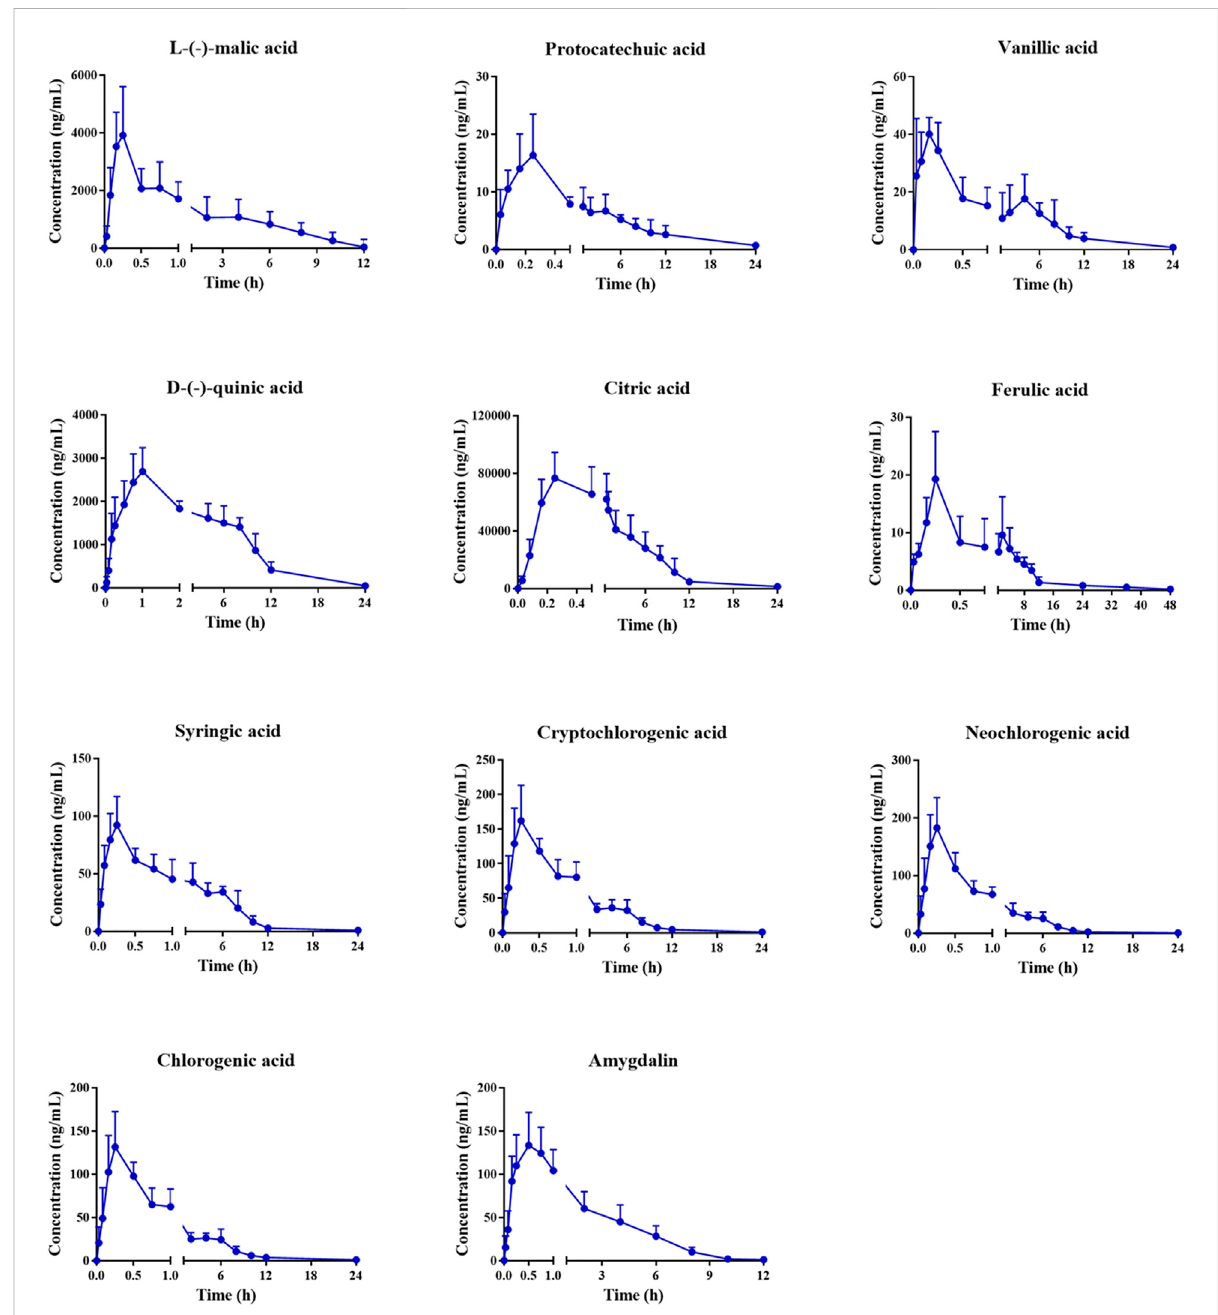
FIGURE 3 Mean plasma concentration – time pro fi les of L-(-)-malic acid, protocatechuic acid, vanillic acid, D-(-)-quinic acid, citric acid, ferulic acid, syringic acid, cryptochlorogenic acid, neochlorogenic acid, chlorogenic acid and amygdalin in rats after oral administration of MF extract.